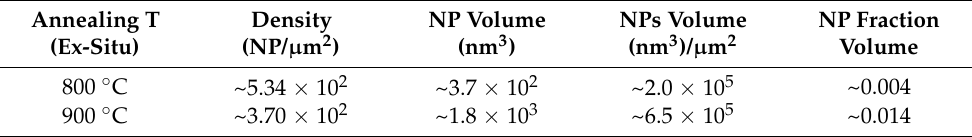
Figure A5. SEM micrographs with a magnification of 200,000× of the same LNMO thin film (thick- ness, t = 48 nm) after different ex-situ annealing temperatures: ( a ) Anneal-800 °C and ( b ) Anneal- 900 °C. Filtered image of its corresponding SEM image ( medium ) and automated grains counting with Image J software ( right ). Table A2. Surface density, average nanoparticle volume, total volume of the nanoparticles (NiO X ) per unit surface (1 µ m 2 ) and nanoparticle fraction volume of the same LNMO thin film after different ex-situ annealing temperatures, determined from Figure A5.